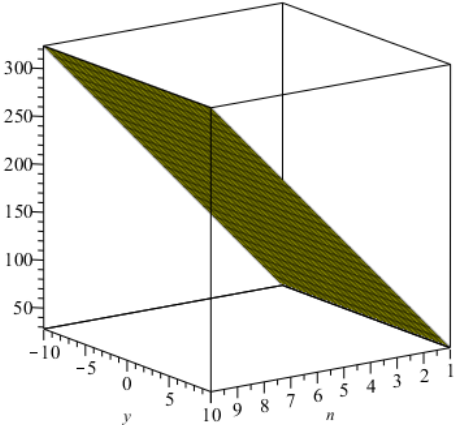
Figure 6. The graphical representation of Balaban index.